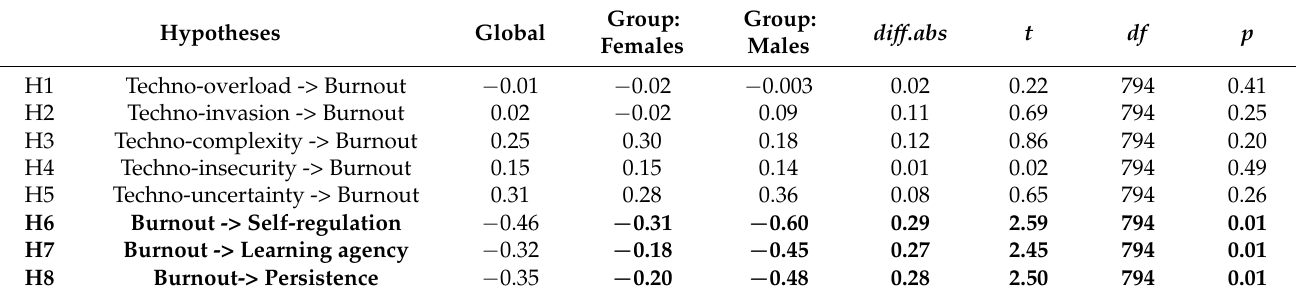
Table 4. Comparison between male and female